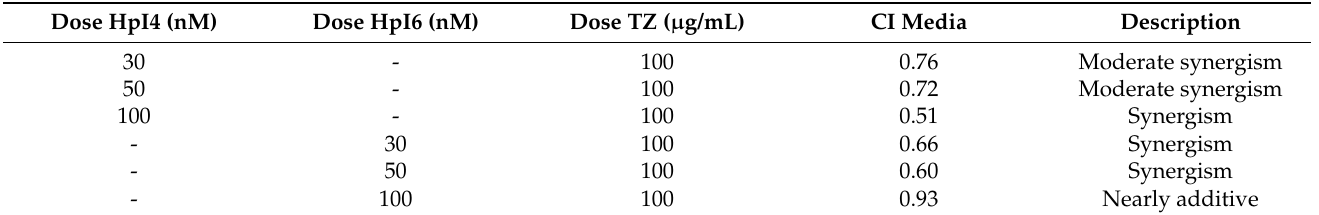
Table 1. Analysis of synergy for the combinations of PPRHs and trastuzumab in SKBR-3